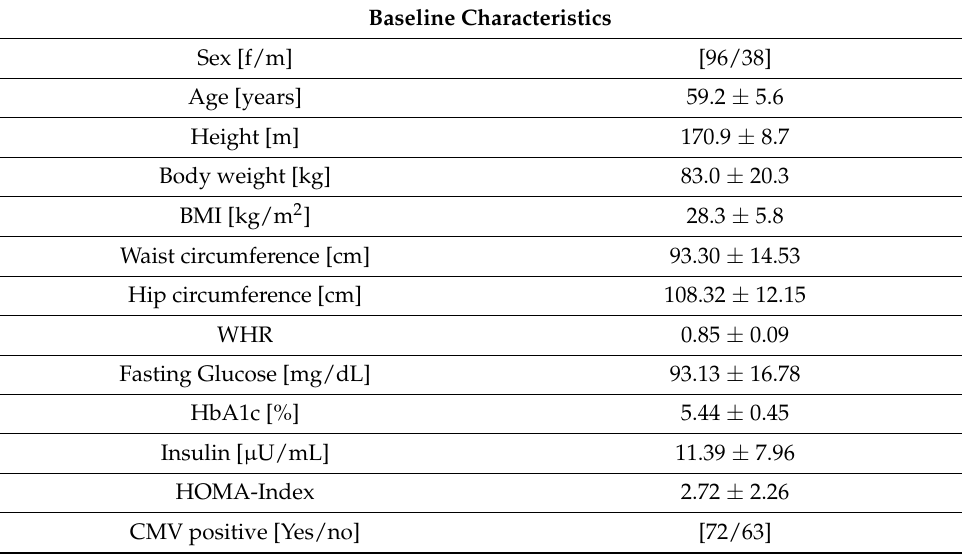
Figure 2. Flow chart of all participants screened and analyzed. Table 1. Baseline characteristics (mean ± SD) of all participants.